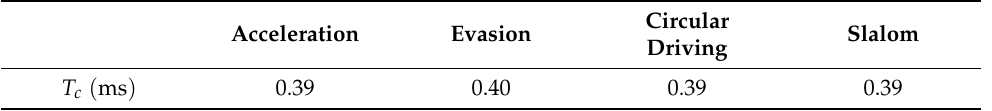
Table 3. Mean computing time on RCP-ECU (Rapid Control Prototyping-Electronic Control Unit) for test